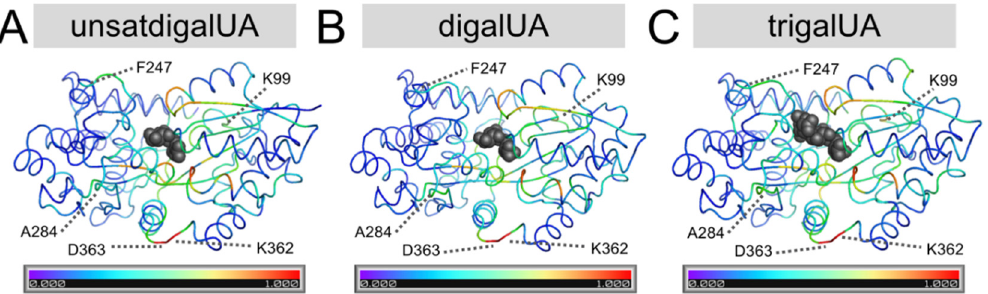
Figure 1. Small-scale changes in amino acid dynamics upon ligand binding identified using F Score2.0 . Average F Score2.0 values for each apo vs. ligand-bound state are projected onto their corresponding PDB structures: TogB bound to unsatdigalUA (( A ), PDB 2UVI), TogB bound to digalUA (( B ), PDB 2UVH), and TogB bound to trigalUA (( C ), PDB 2UVJ). Ligand is shown using grey spheres, and protein backbone is shown as a ribbon, coloured according to F Score2.0 values. Candidate labeling positions selected based on F Score2.0 values are also indicated.